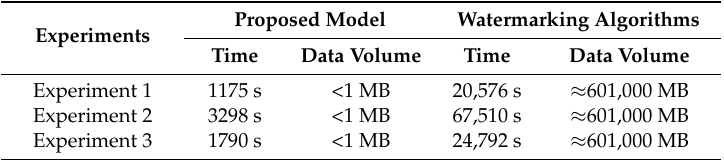
Table 6. Computation time and processed data volume cost by the proposed model and